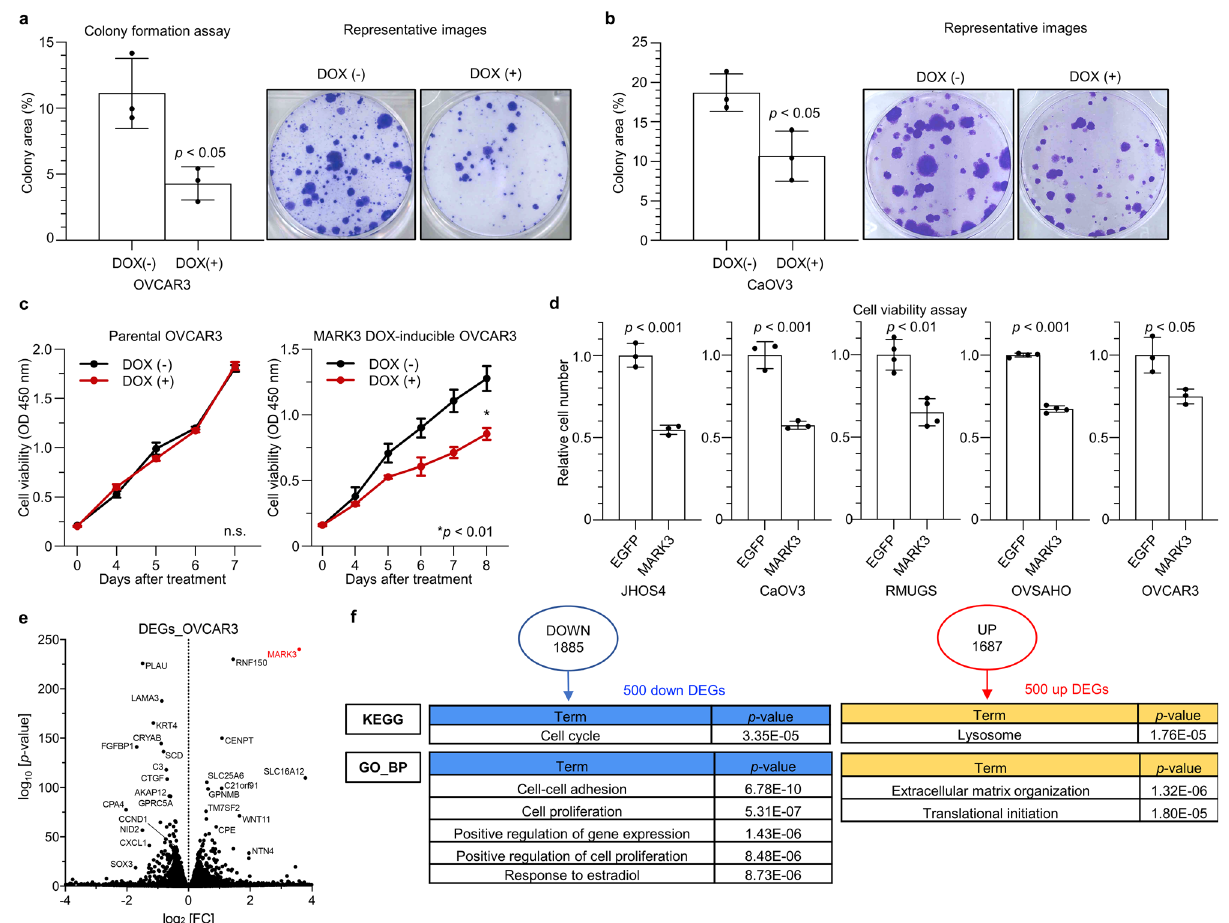
Fig. 3 MARK3 overexpression inhibits cell proliferation in HGSOC cell lines. a , b Colony formation assay in MARK3 doxycycline (DOX)-inducible OVCAR3 ( a ) and CaOV3 ( b ) cells. Error bars represent mean ± standard deviation (SD) of three biological replicates. Statistical analysis was performed using an unpaired Student ’ s t -test. c Cell viability assay in parental OVCAR3 and MARK3 DOX-inducible OVCAR3. To exclude the potential